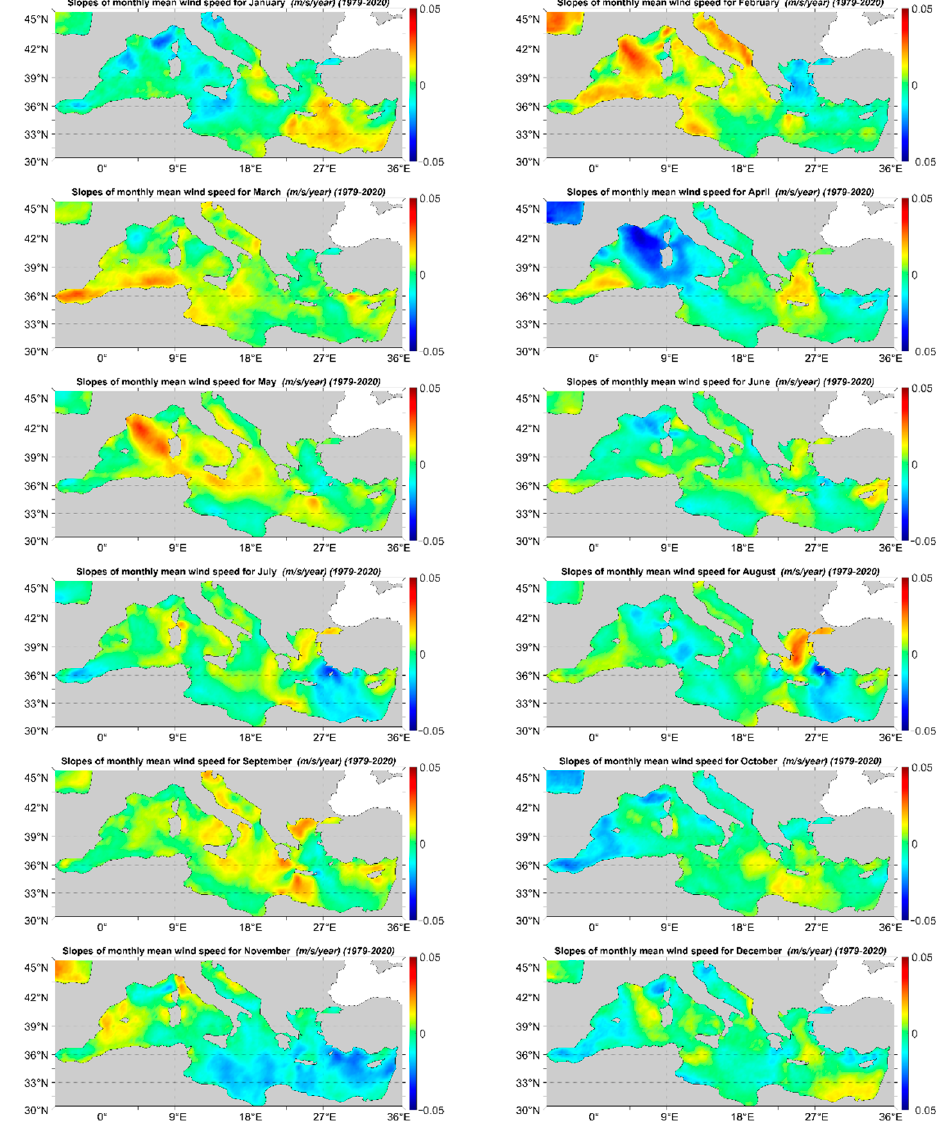
Figure 16. Linear slope of monthly mean wind speed.